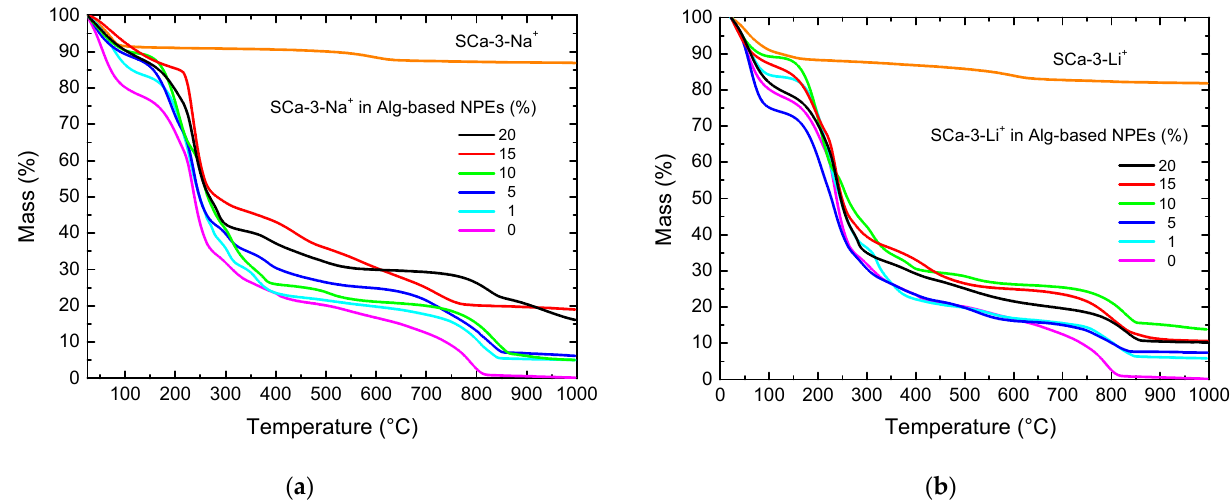
Figure 2. Thermograms for SCa-3-Na + and SCa-3-Li + clays and Alg-based NPEs with 0–20 wt% of ( a ) SCa-3-Na + and ( b ) SCa-3-Li + .